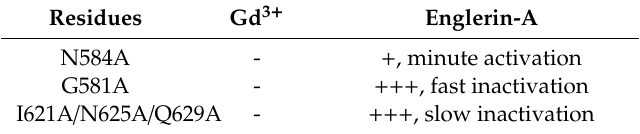
Table 1. Result of site-directed mutagenesis targeted for residues in ion conduction